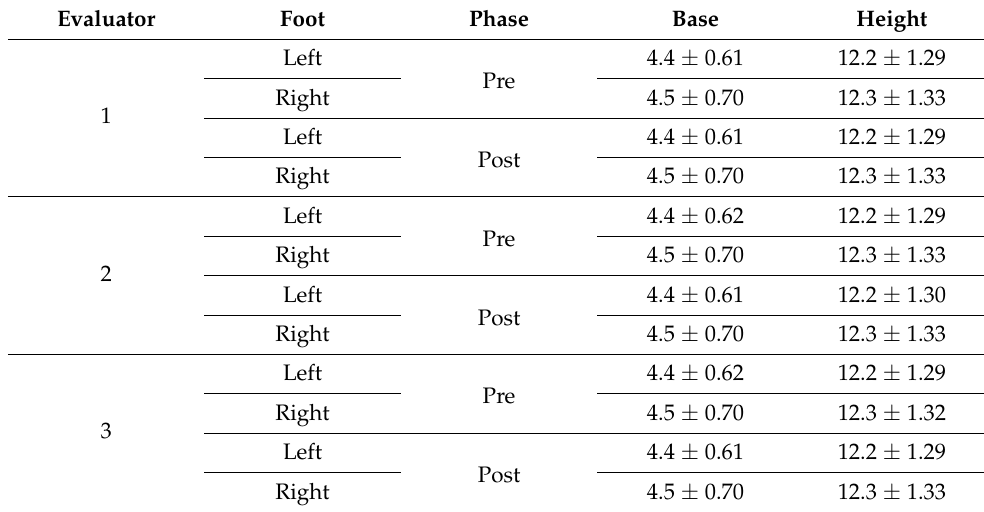
Table 1. Intra-rater reliability. Mean and standard deviation of h and b measurements ( p < 0.05).